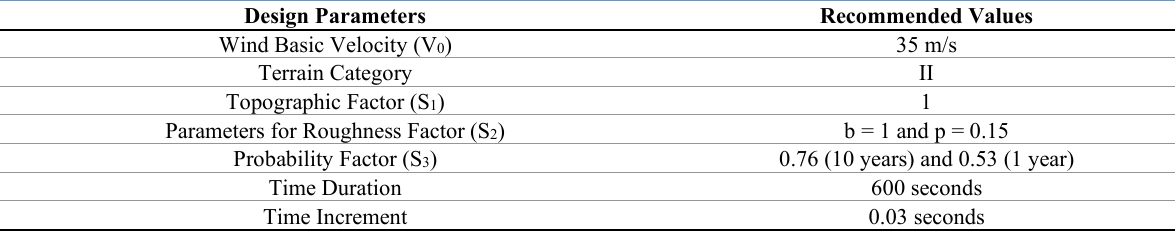
Table 2 P arameters used to generate the nondeterministic wind series.